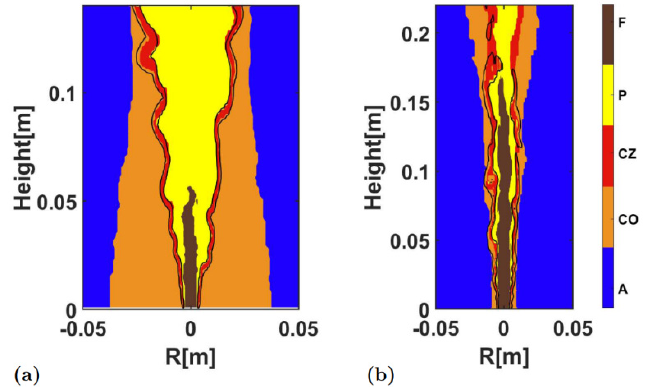
Figure 6. The clustering analysis results are compared with the HRR (20% of the maximum) isolines: